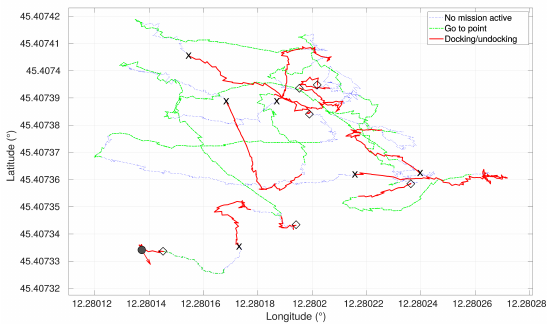
Figure 23. Full mission trajectory of the Venice docking experiment in challenging conditions. The aPad is represented by a black circular marker and its heading denoted by a red arrow. The X markers designate successful docking attempts, while the black diamond markers signify